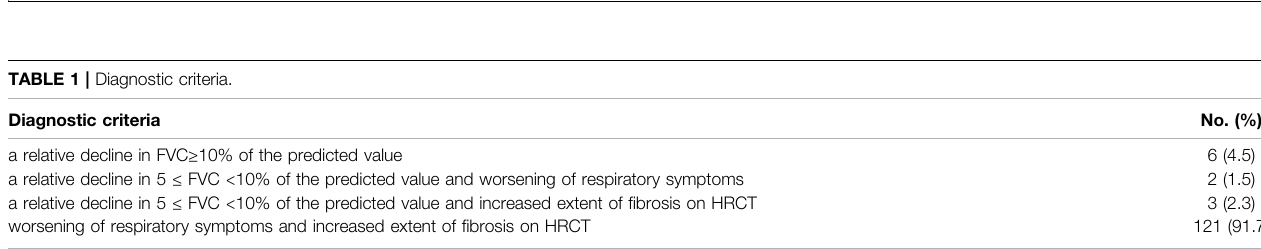
TABLE 1 | Diagnostic